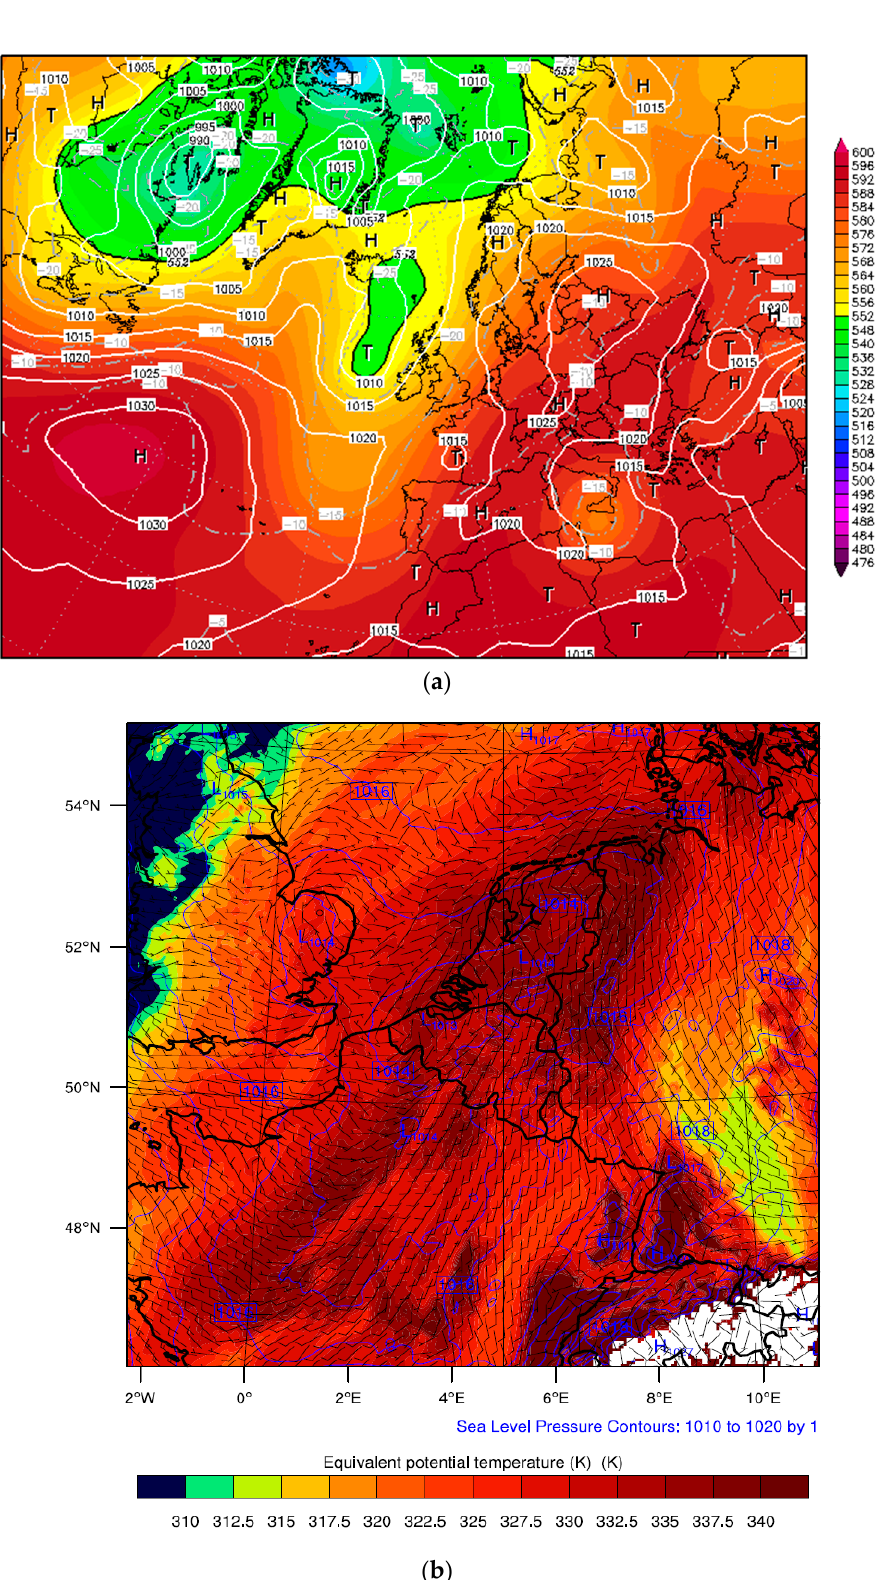
Figure 2. ( a ) GFS surface and upper-air reanalysis for 23 June 2016 at 00:00 UTC for Europe and the Atlantic. White lines: surface pressure; grey dashed line: temperature at 500 hPa level. Colours: height of the 500 hPa level (gpdam). Source: www.wetterzentrale.de. ( b ) Regional weather map for 23 June 2016 at 14:00 UTC indicating the Weather Research and Forecasting (WRF) modelled equivalent potential temperature at 850 hPa and sea-level pressure (blue lines) and wind (wind barbs).